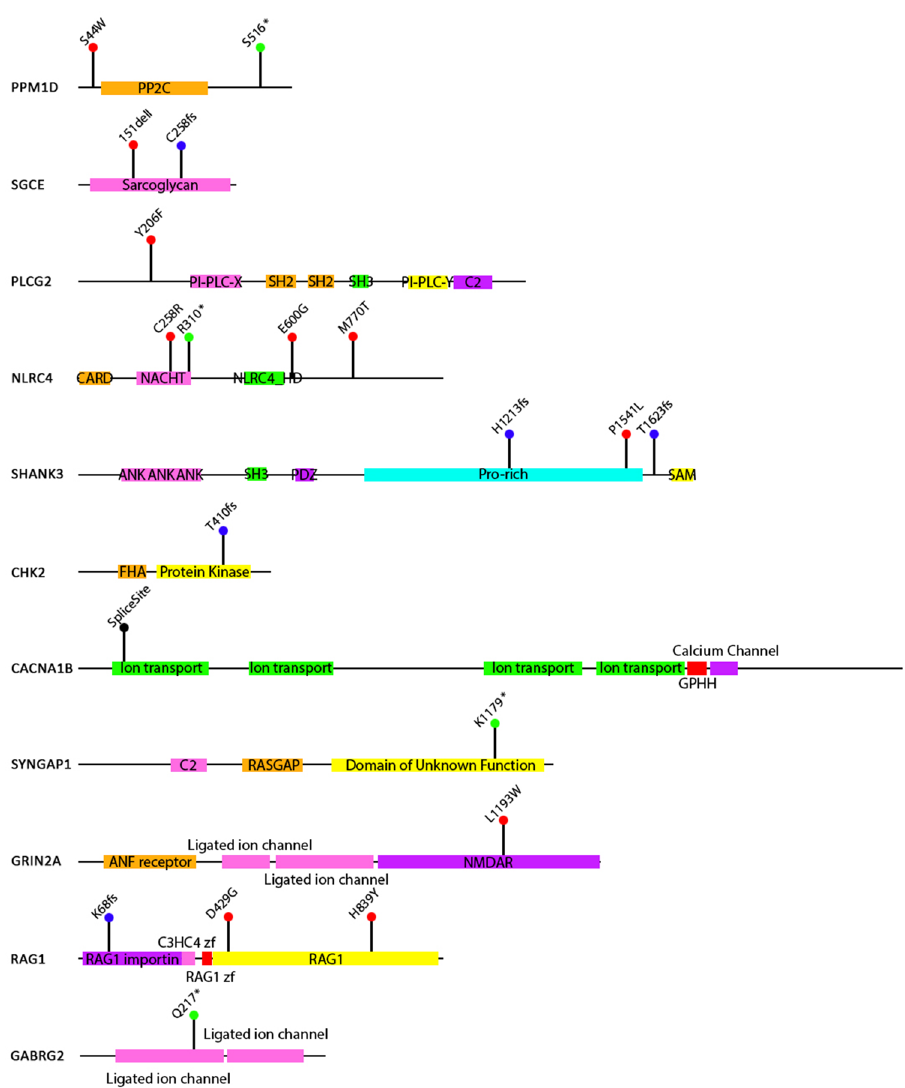
Figure 1. Position of PANS ultra-rare variants within each candidate